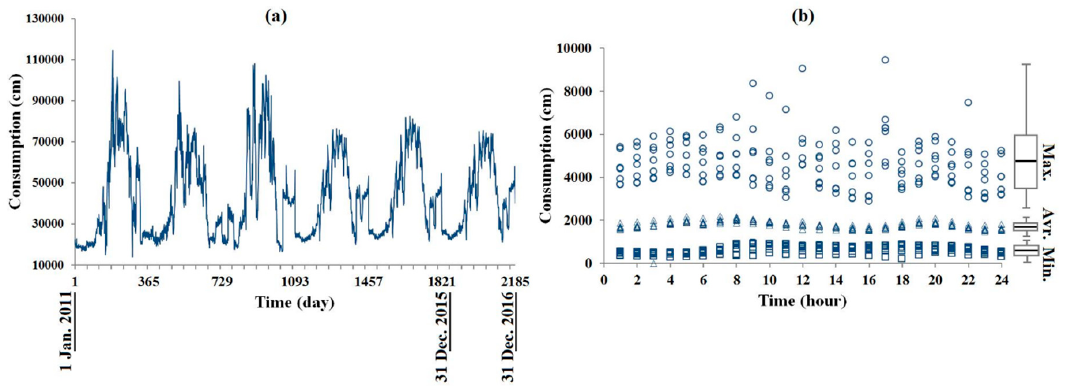
Figure 3. Time series plot of ( a ) daily water consumption; ( b ) 6-years consumption pattern within a 24-h period.